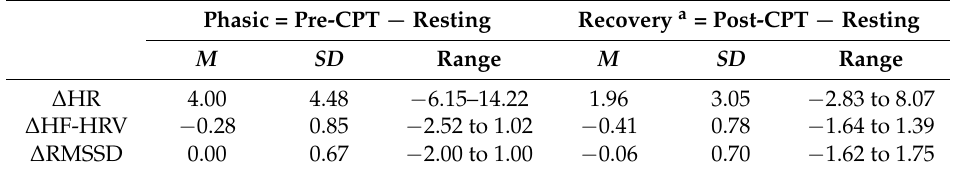
Table 2. Descriptive Statistics of the HR, HF-HRV, and RMSSD Change Scores ( N = 25). Phasic = Pre-CPT − Resting Recovery a = Post-CPT −